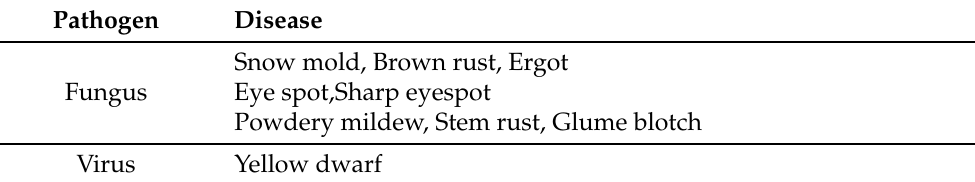
Table 8. Some Rye disease types and causing pathogens